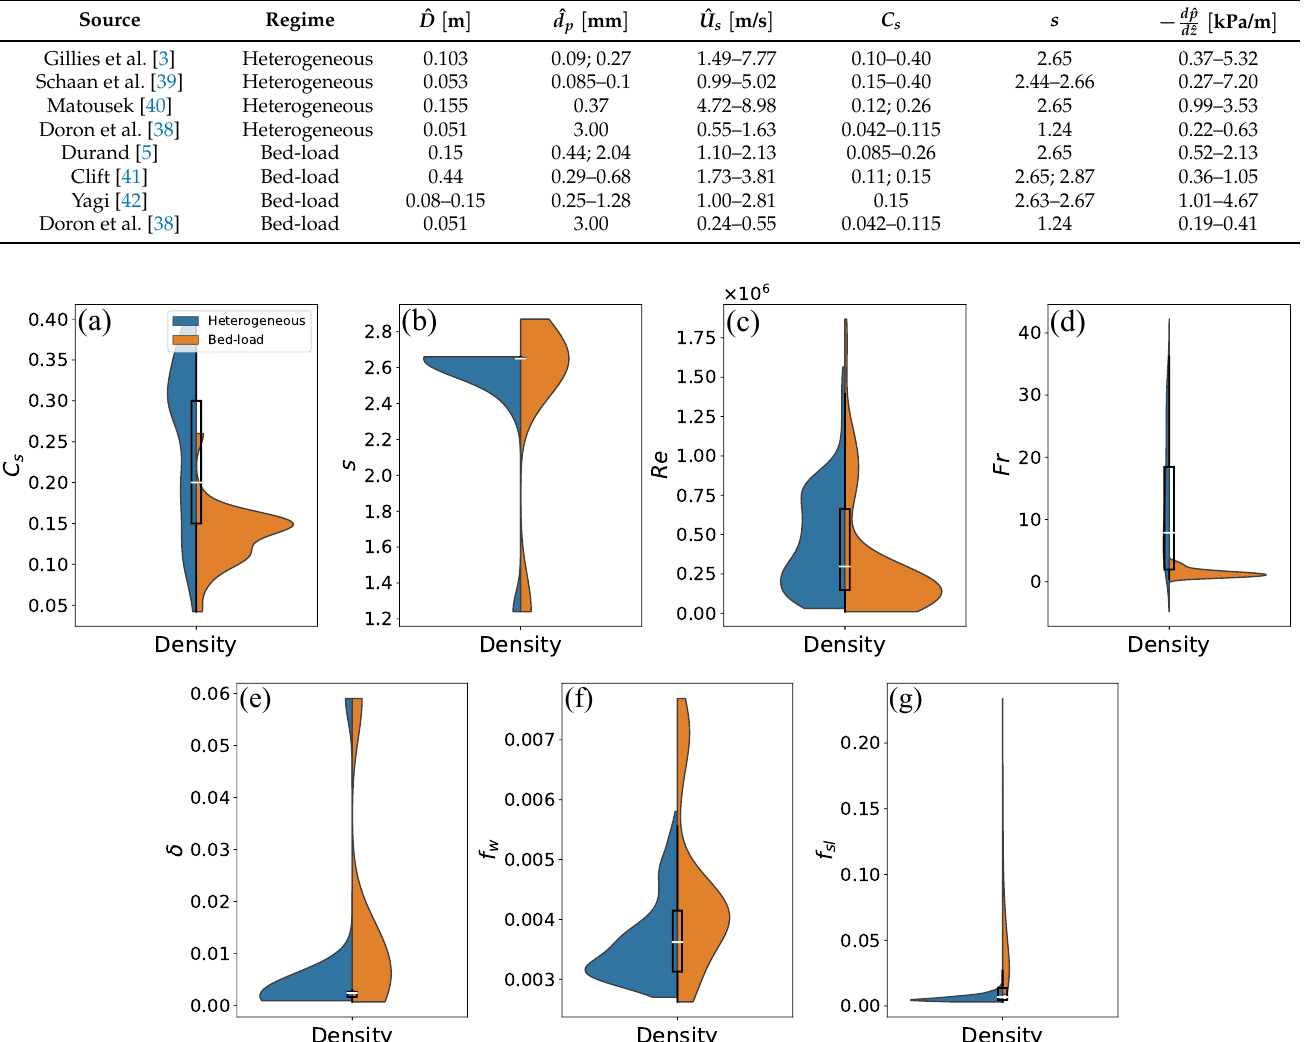
Figure 9. Kernel density distribution and box plot of all the input features ( C v , s , Re , Fr , δ , f w ) and the output ( f sl ) ( a–g , respectively) for the slurry friction factor prediction model in heterogeneous and bed-load